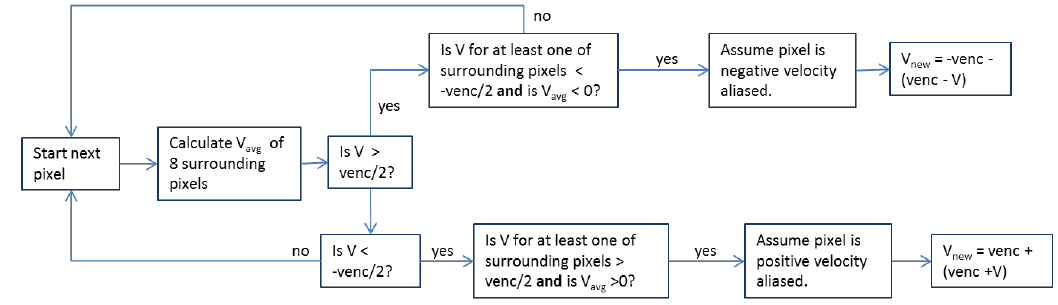
Figure 1. Anti-aliasing algorithm logic chart.